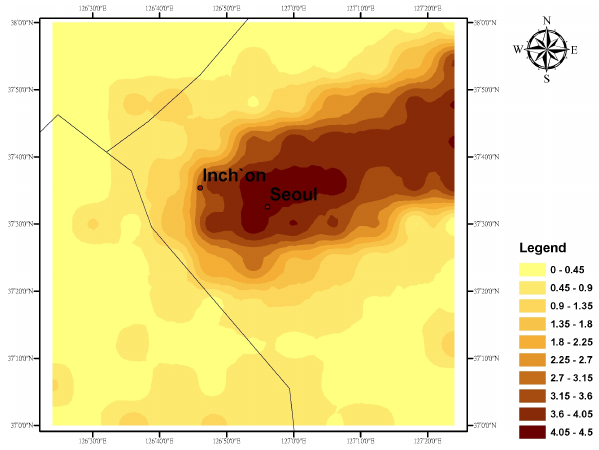
Fig. 4. Spatial distribution of percent positive flashes over Seoul for the years